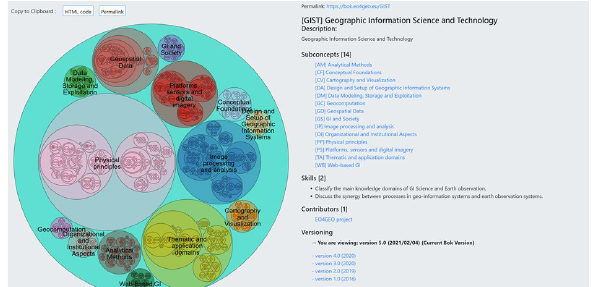
Figure 2 . The EO4GEO BoK in the BoK Visualisation and Search tool 2